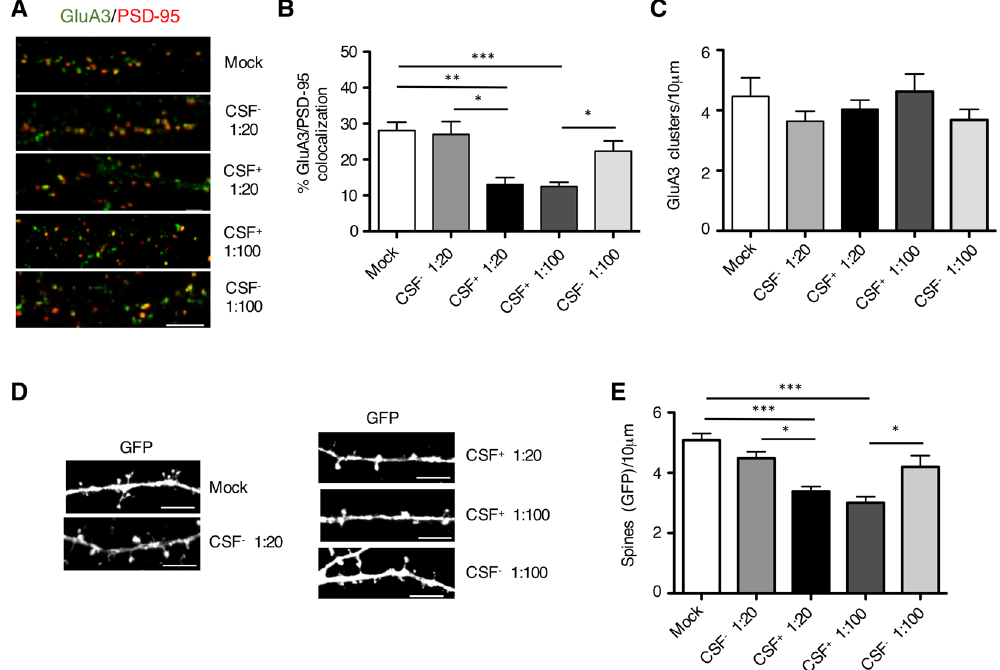
Figure 4. Neurobiological effect of GluA3 antibodies in primary rat neurons. ( A ) Fluorescence immunocytochemistry of GluA3 (green), PSD-95 (red) and MAP2 (blue) in DIV14 neurons treated with CSF with (CSF + ) or without (CSF − ) anti-GluA3 antibodies at two different dilutions (1:20 and 1:100) for 24 hours. Scale bar, 5 μ m. ( B ) Bar graph representing the percentage of co-localization of GluA3 with PSD-95. Data are presented as mean ± s.e.m, n = 14, one-way ANOVA followed by Tukey as post hoc test; * p < 0.05, ** p < 0.01, *** p < 0.001. ( C ) Bar graph representing the density of GluA3 positive cluster along dendrites. Data are presented as mean ± s.e.m., n = 14, one-way ANOVA followed by Tukey as post hoc test. ( D ) Confocal images of rat primary hippocampal neurons transfected at DIV8 with GFP and immunolabeled at DIV14 for GFP (green). Scale bar: 5 μ m. ( E ), Bar graph showing the quantification of dendritic spine density. Data are presented as mean ± s.e.m., n = 6–8, one-way ANOVA followed by Tukey as post hoc test; * p < 0.05, ** p < 0.01, *** p < 0.001.